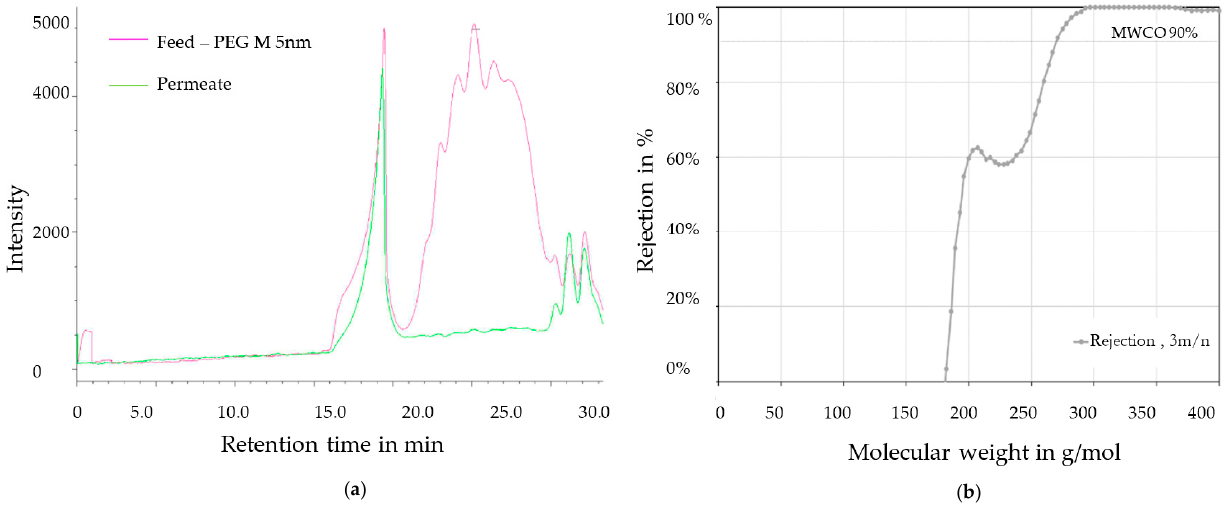
Figure 8. ( a ) Chromatogram of polyethylene glycol (PEG) mixture before and after filtration using a hybrid membrane. ( b ) Rejection of PEG as a function of their molecular weight.